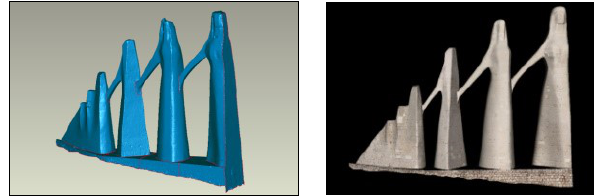
Figure 8: Virtual restoration of the Zalongon monment